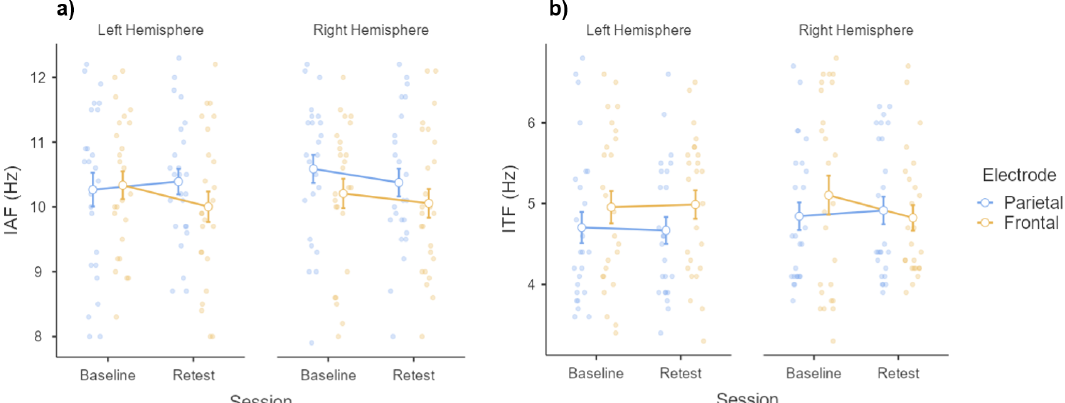
Figure 4. Estimated marginal means and error bars expressed as 95% standard errors. The graphs show observed scores relative to IAFs and ITFs (y-axes) as a function of testing session (x-axes, baseline vs. retest), sorted according to the hemisphere (left vs. right) and electrode location (parietal vs. frontal). Panel ( a ) shows IAFs (y-axis) as a function of the testing session (x-axis), recorded from parietal (blue dots) and frontal (orange dots) electrodes relative to the left (leftmost graph) and right (rightmost graph) hemisphere. Panel ( b ) shows ITFs (y-axis) as a function of the testing session (x-axis), recorded from parietal (blue dots) and frontal (orange dots) electrodes relative to the left (leftmost graph) and right (rightmost graph) hemisphere.